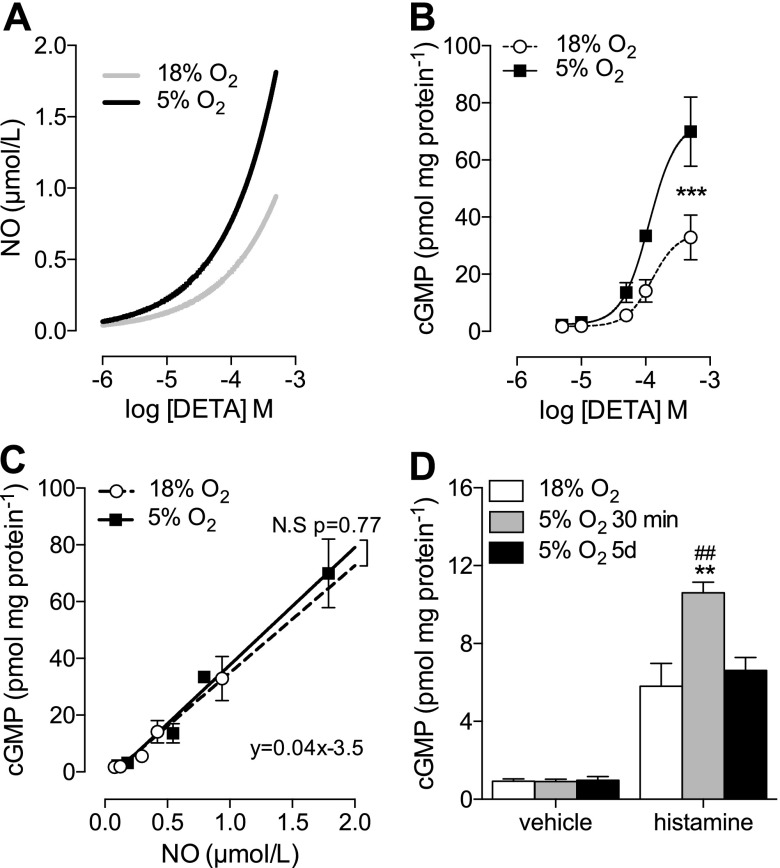
Impact of O2 on NO bioavailability in endothelial cells. A) Modeling of NO release from different levels of DETA after 10 min of decomposition. B) HUVECs were maintained at 18% O2 or cultured in 5% O2 for at least 5 d. Cells were treated with DETA (0–500 µM, 10 min), and cGMP production was assayed. Vehicle (NaOH 0.05%) had no effect on cGMP production (not shown). C) Correlation of predicted [NO] with measured cGMP levels. Differences in neither slope nor intercept were significant when 18 and 5% O2 were fitted separately, so one equation represents both O2 levels. D) Histamine (10 µM, 5 min) stimulated cGMP levels in HUVECs cultured in 18% O2 and then exposed acutely to 5% O2 for 30 min. Treatment with histamine was significant (P < 0.05 vs. respective control). Data are means ± sem (n = 3–9 different donors). **P < 0.01, ***P < 0.001 vs. 18% O2; ##P < 0.01 vs. 5% O2 (5 d).